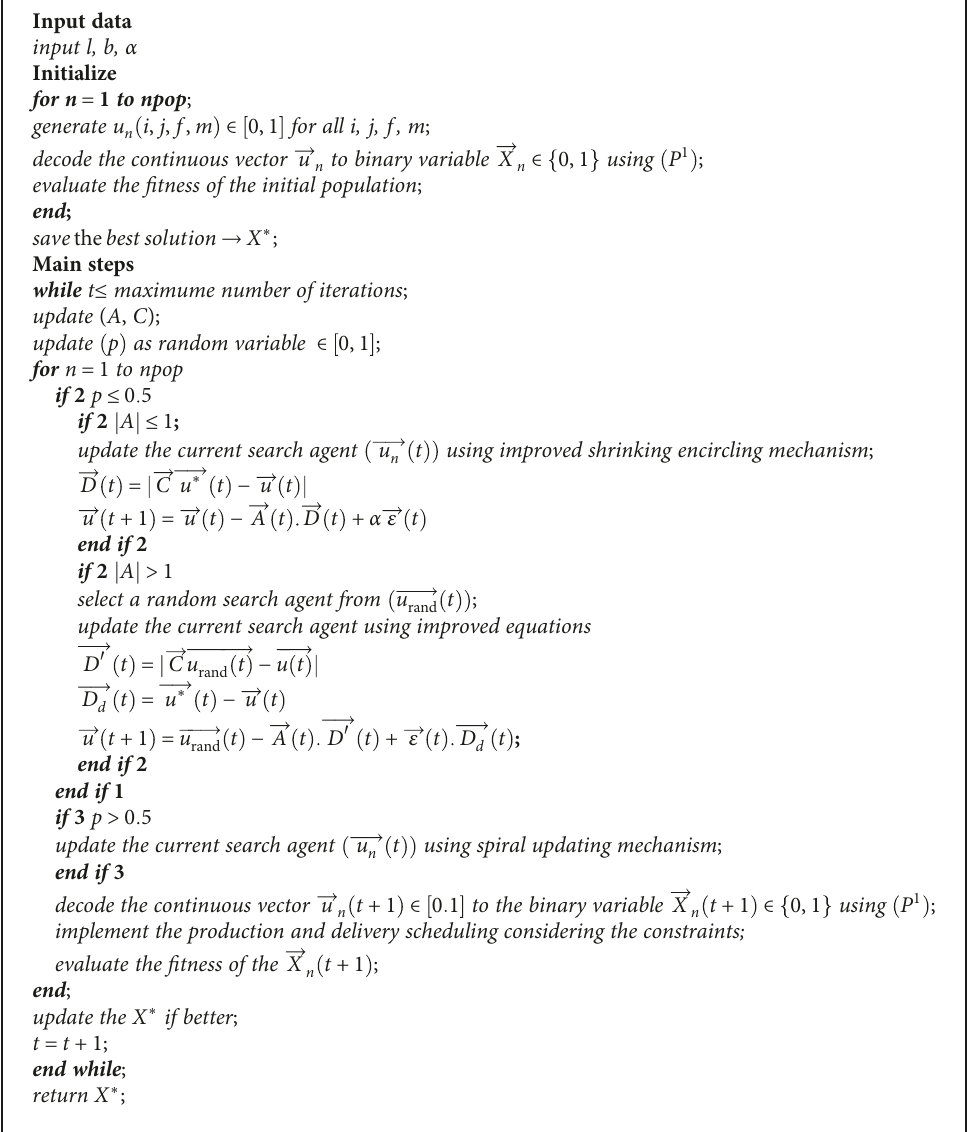
Algorithm 2: Pseudocode for Improved